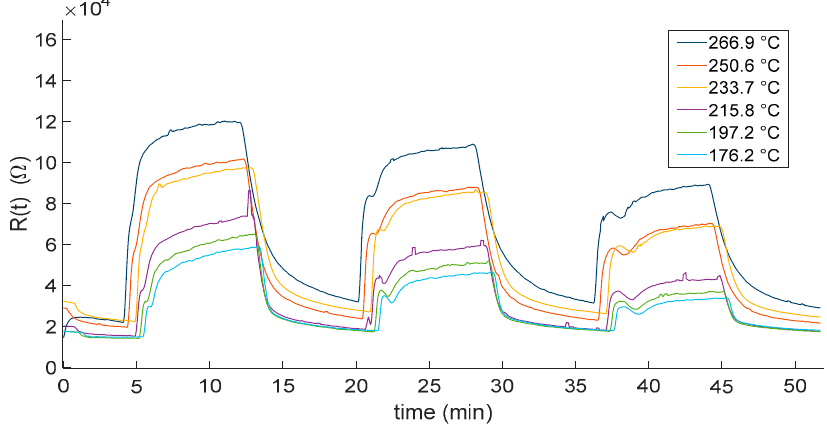
Figure 7. Measured In 2 O 3 − x sensor response as a function of time when gas pulses (8 min long) consisting of mixtures of N 2 and NO 2 (10, 5 and 2.5 ppm) are injected into the measurement chamber. Gas pulses are followed by recovery phases (8 min long) in pure dry N 2 . Di ff erent colors represent responses obtained at the di ff erent working temperatures (see legend).